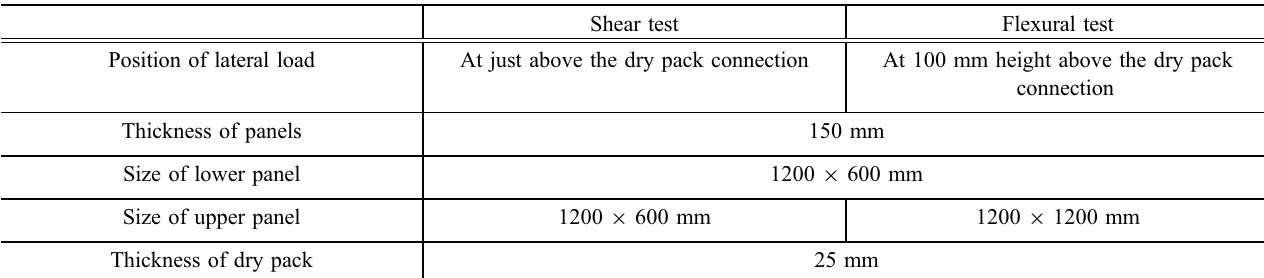
Fig. 7 Details and instrumentation of wall assembly specimen (unit: mm). Table 3 Size of wall panels for shear and flexural